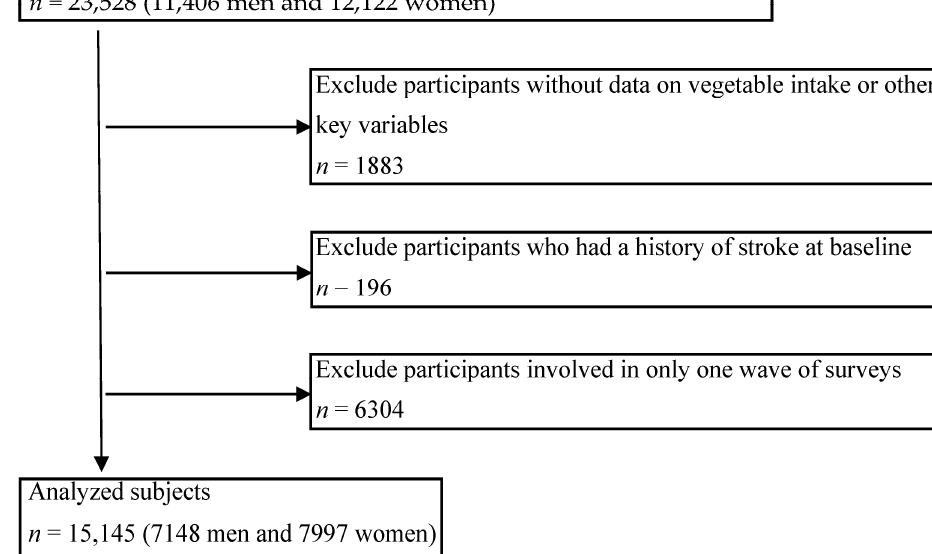
Figure 1. Flowchart for the selection of analyzed cohort .